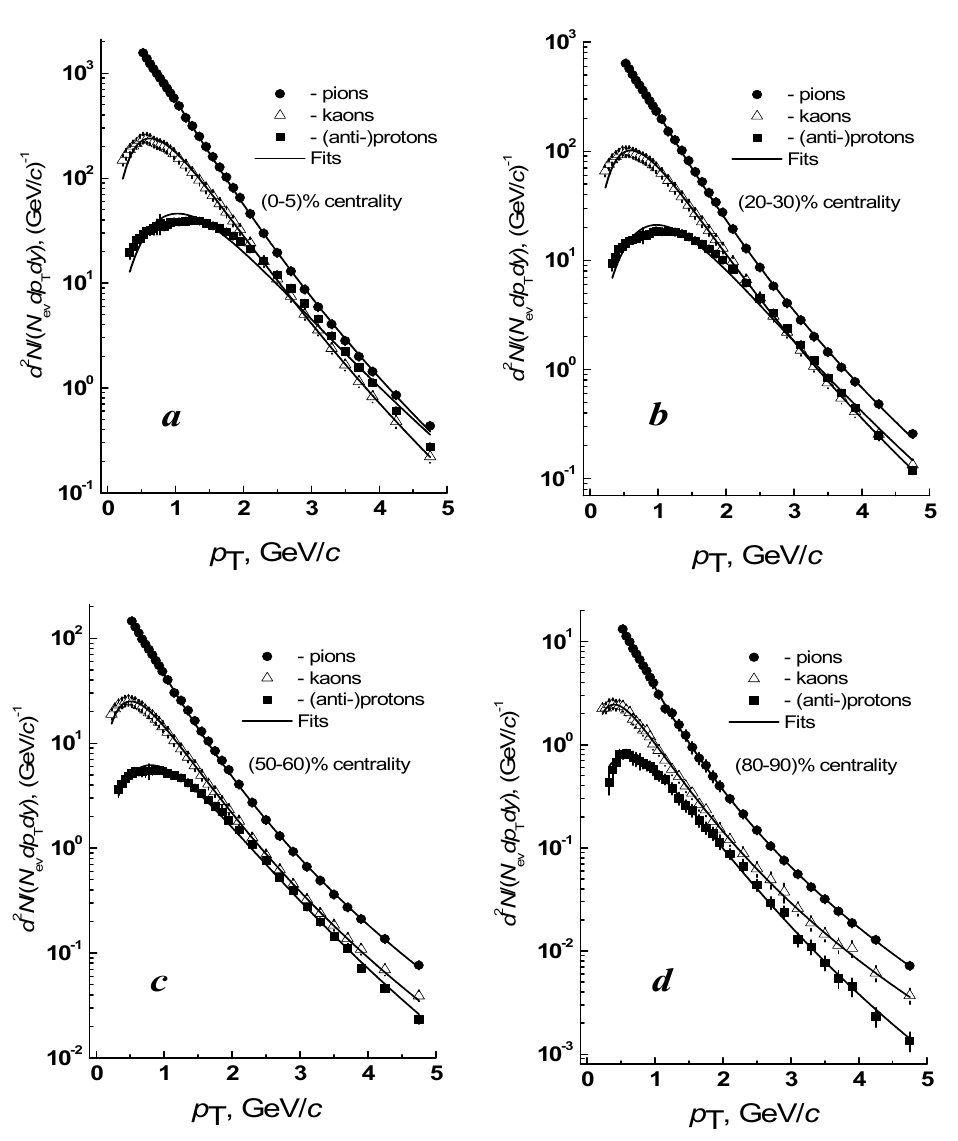
Figure 2. The obtained fit curves by non-consistent (simple) Tsallis function with transverse flow (Equation (4)) of the experimental midrapidity transverse momentum spectra of the charged pions ( ● ), kaons ( Δ ), and protons and antiprotons ( ▪ ) in Pb + Pb collisions at (cid:3493)𝑠 (cid:3041)(cid:3041) = 5.02 TeV at various centralities: 0–5% ( a ), 20–30% ( b ), 50–60% ( c ), and 80–90% ( d ).